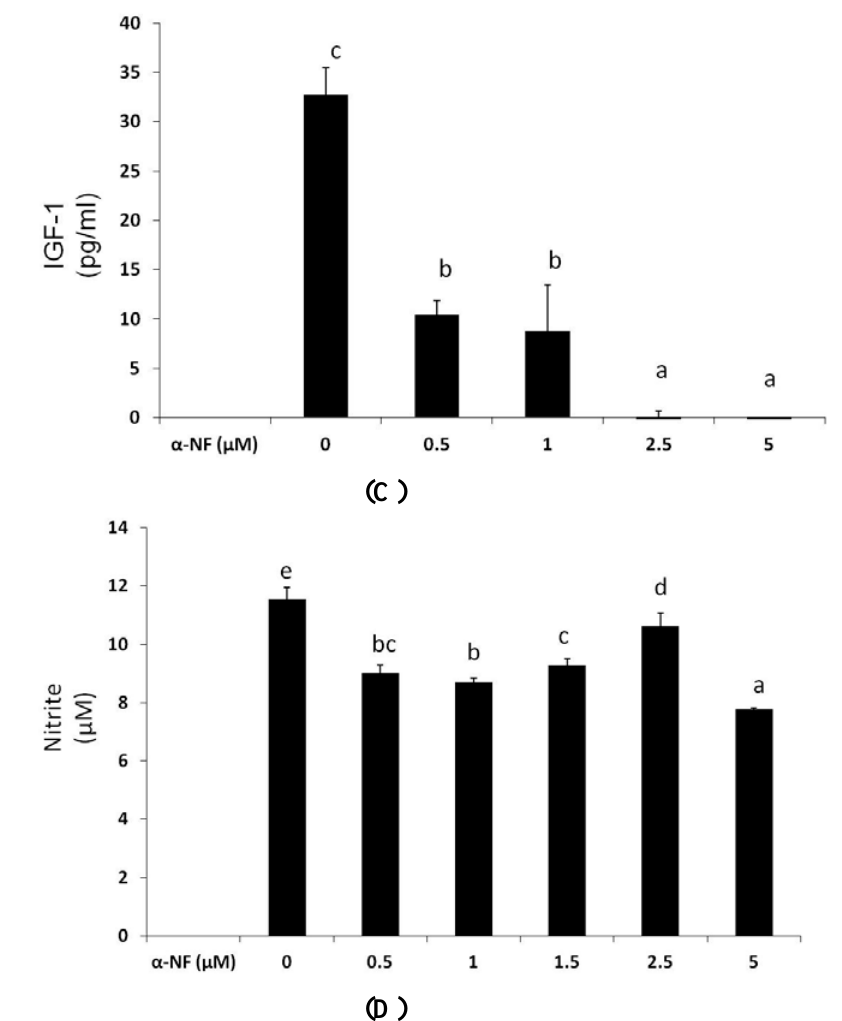
Figure 4. Effect of α-naphthoflavone (α-NF) on vascular endothelial growth factor (VEGF) ( A ), interleukin (IL)-6 ( B ), nitric oxide (NO) ( C ), and insulin growth factor (IGF)-1 ( D ) secretion in culture medium from differentiated adipocytes. After full differentiation, adipocytes were treated with various concentrations of α-NF in Dulbecco’s modified Eagle’s medium (DMEM) containing 1% fetal bovine serum (FBS) for 16 h. The medium was collected to analyze nitrite using the Griess reagent, IGF-1, VEGF, and IL-6 by ELISA kits. Values are the mean ± SD from three measurements, and data with different letters significantly differ ( p <